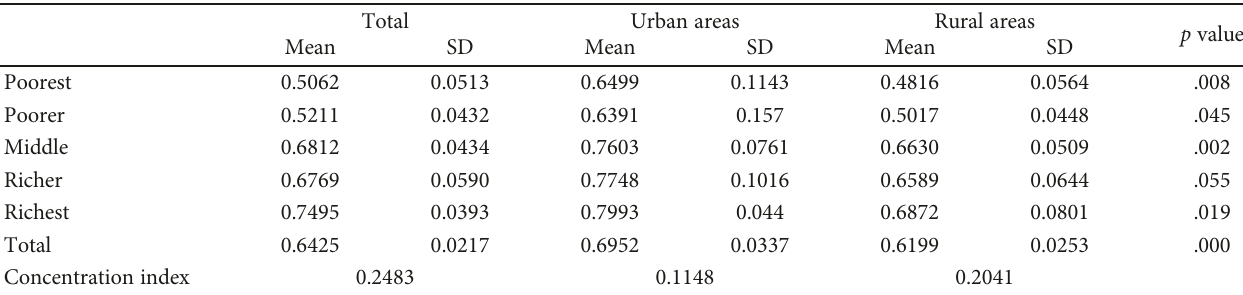
Table 3: Incidence of receiving antidiabetic medication and concentration index among middle-aged and elderly diabetes patients.